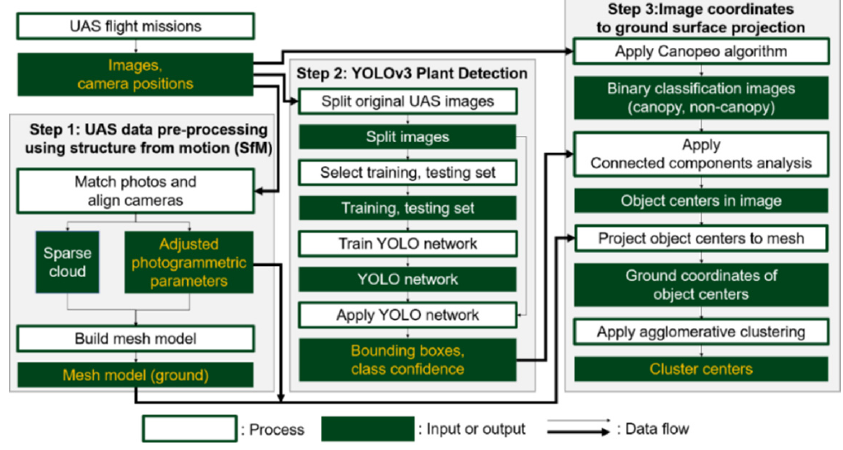
Figure 3. Plant counting procedure using Unmanned Aircraft Systems (UAS) and the You Only Look Once version 3 (YOLOv3) object detection algorithm.